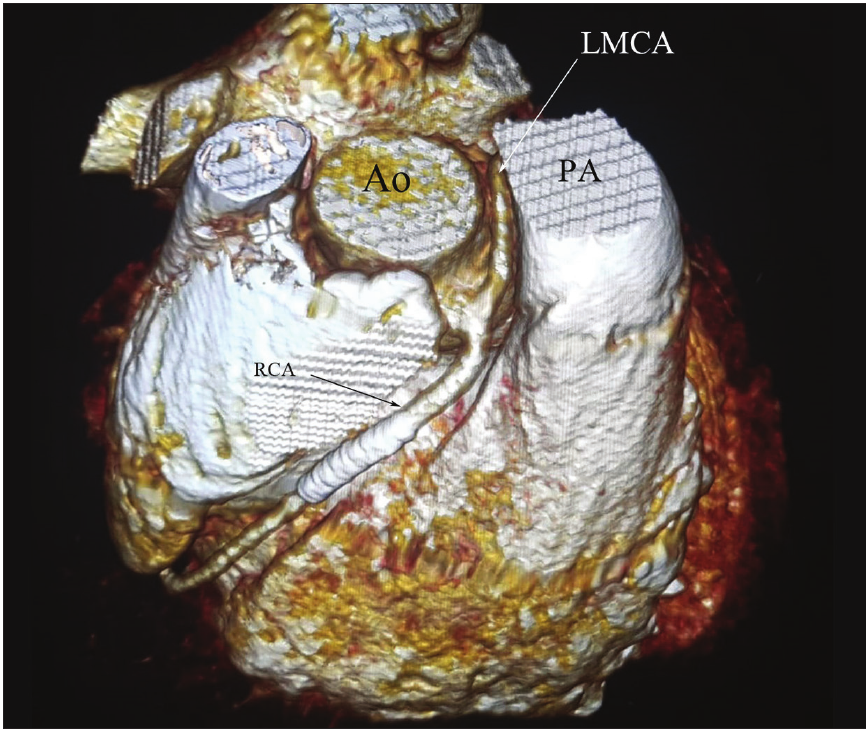
Figure 2. Three-dimensional reconstruction computerized tomography image demonstrating the course of the LMCA between the Ao and the PA. LMCA: left main coronary artery; Ao: ascending aorta; PA: pulmonary